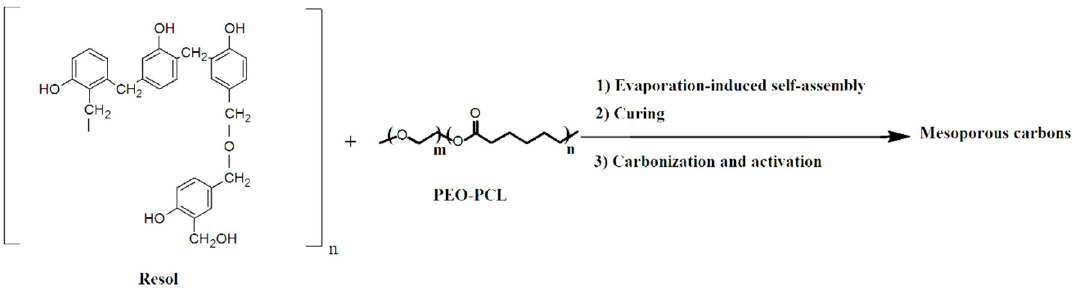
Figure 5. Preparation of mesoporous